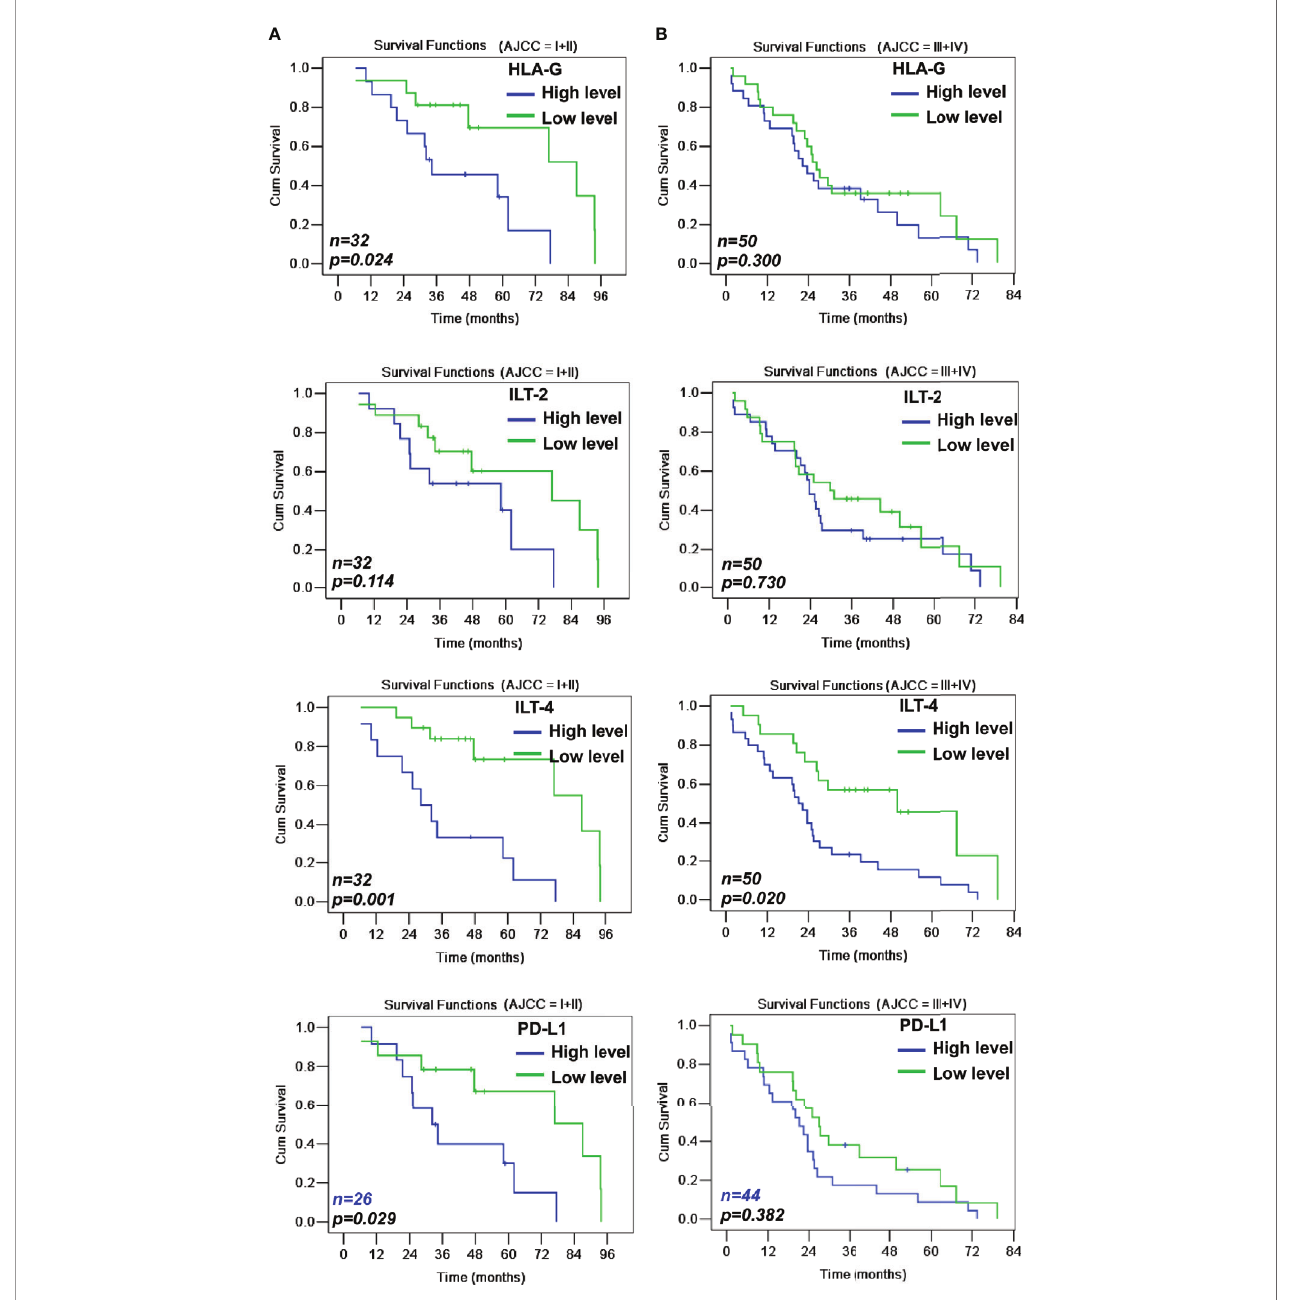
FIGURE 4 | Kaplan-Meier survival analysis of low and high levels of HLA-G, ILT-2, ILT-4 and PD-L1 for survival either in AJCC stage I+II (A) or in AJCC stage III+IV (B) CRC